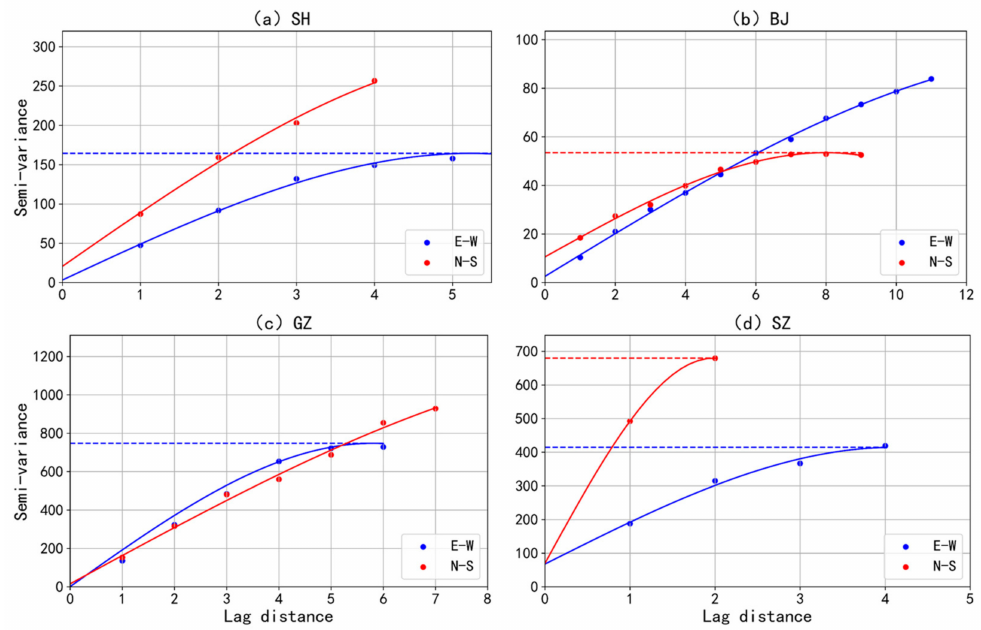
Figure 11. Semi-variance analysis for two directions: east–west and